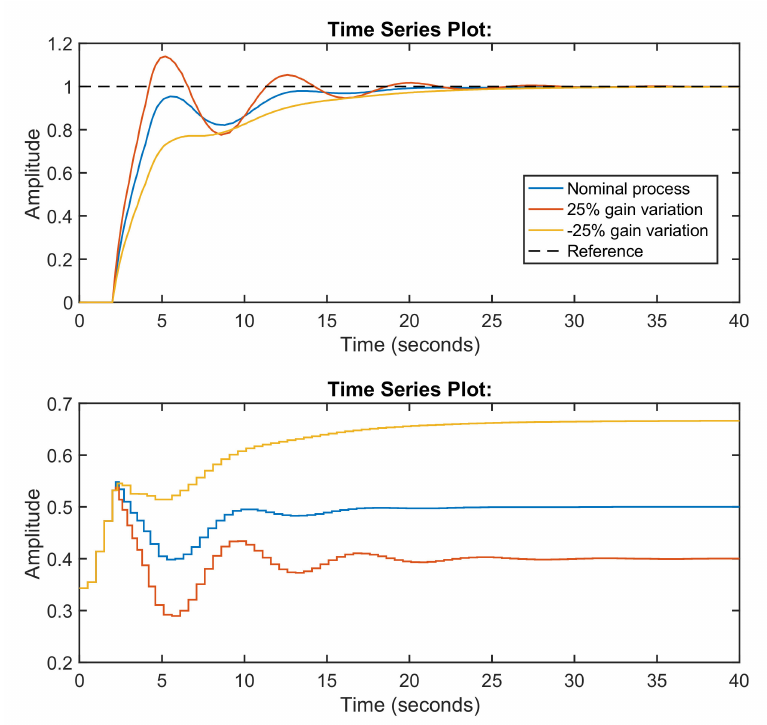
Figure 13. Robustness validation of the event-based PI controller (output signal in the upper plot, input signal in the lower